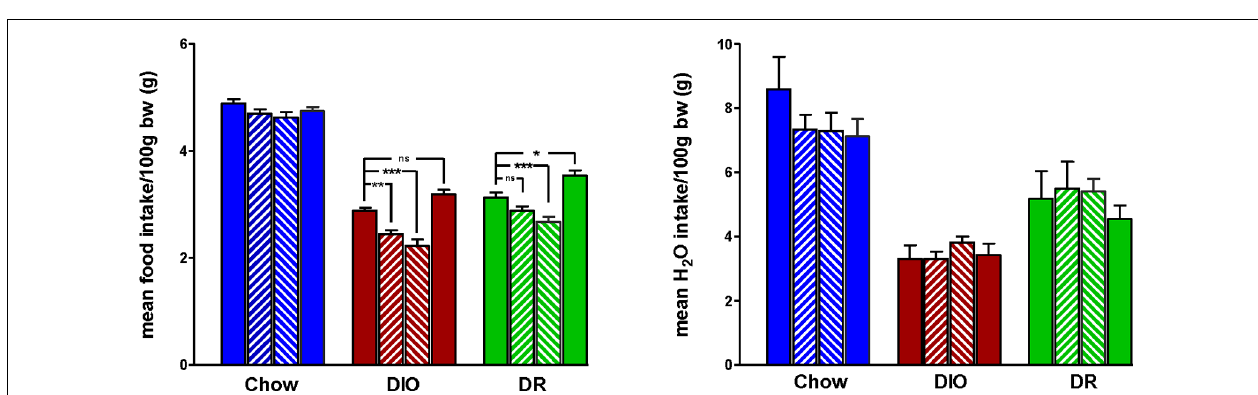
FIGURE 3 |Average daily weight gain in age-matched control rats fed standard rat chow (CHOW; left) or in DIO rats (middle) or DR rats (right), immediately prior to losartan treatment (Pre), days 1–7 (LOS 1–7) and days 8–14 (LOS 8–14) of losartan treatment and the